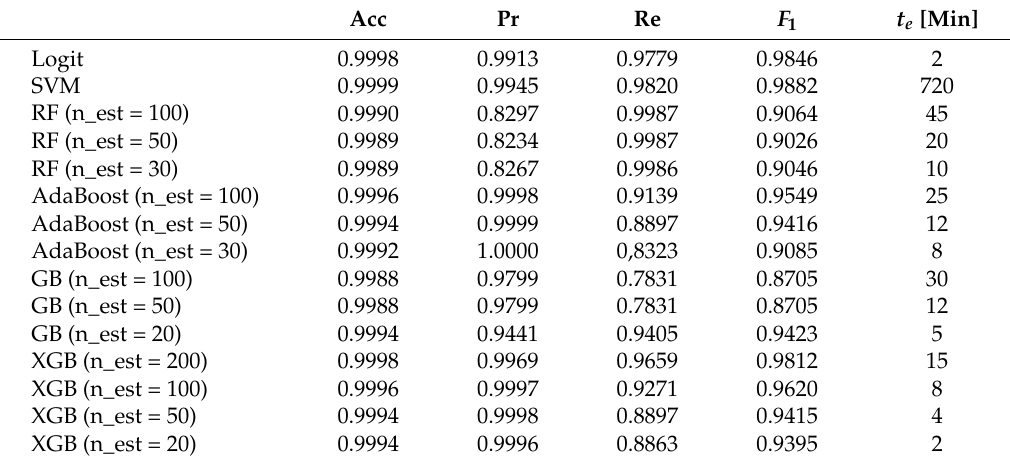
Table 1. Outcomes obtained on simulated PPE images from the six classifiers: Logistic Regression (Logit), Support Vector Machine (SVM), Random Forest (RF), Adaptive Boosting (AdaBoost), Gradient Boosting (GB) and eXtreme Gradient Boosting (XGB). All these learners were evaluated on four parameters: Accuracy (Acc), Precision (Pr), Recall (Re) and F 1 score; moreover, the execution time was taken into account ( t e in minutes).